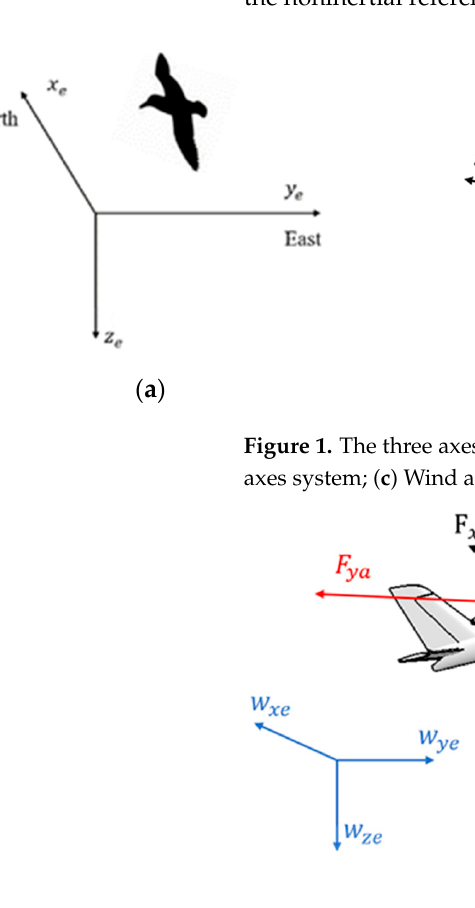
Figure 2. The forces acting on the UAV model.